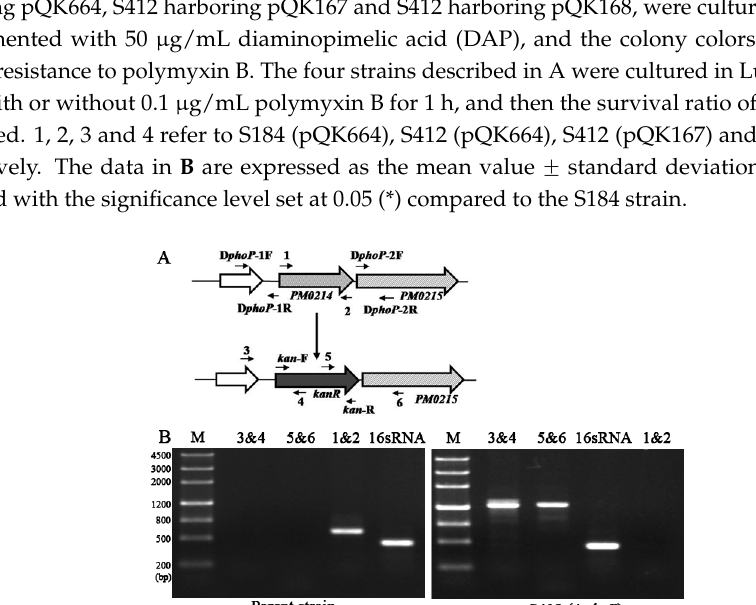
Figure 2. Construction of the Δ phoP mutant in P. multocida strain 0818. ( A ) Schematic strategy for deletion of the target phoP gene (PM0214) by single-crossover recombination. The targeted phoP gene of P. multocida 0818 was replaced with a kanR cassette through homologous recombination. The primers termed 1, 2, 3, 4, 5 and 6 were designed for selection and characterization of the mutant clones; ( B ) Characterization of the constructed ∆ phoP mutant. The parent strain and the ∆ phoP mutant were identified with three primer pairs: 1&2, 3&4 and 5&6. The theoretical sizes of the PCR products from primer pairs of 1&2, 3&4, 5&6 and 16sRNA-F/R were 672, 1168, 1282 and 501 bp, respectively. M refers to the DNA marker; 16S RNA denotes amplification of the positive-control gene in both